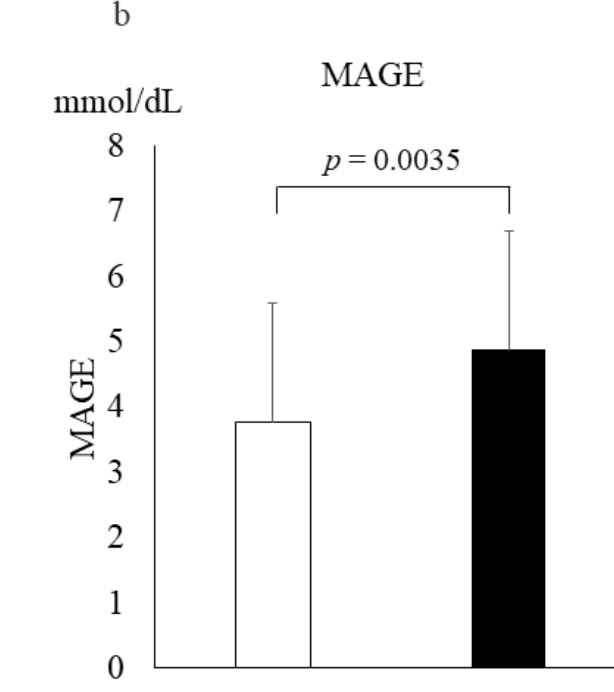
Table 2. Clinical variables recorded in stage 2 of the trial.